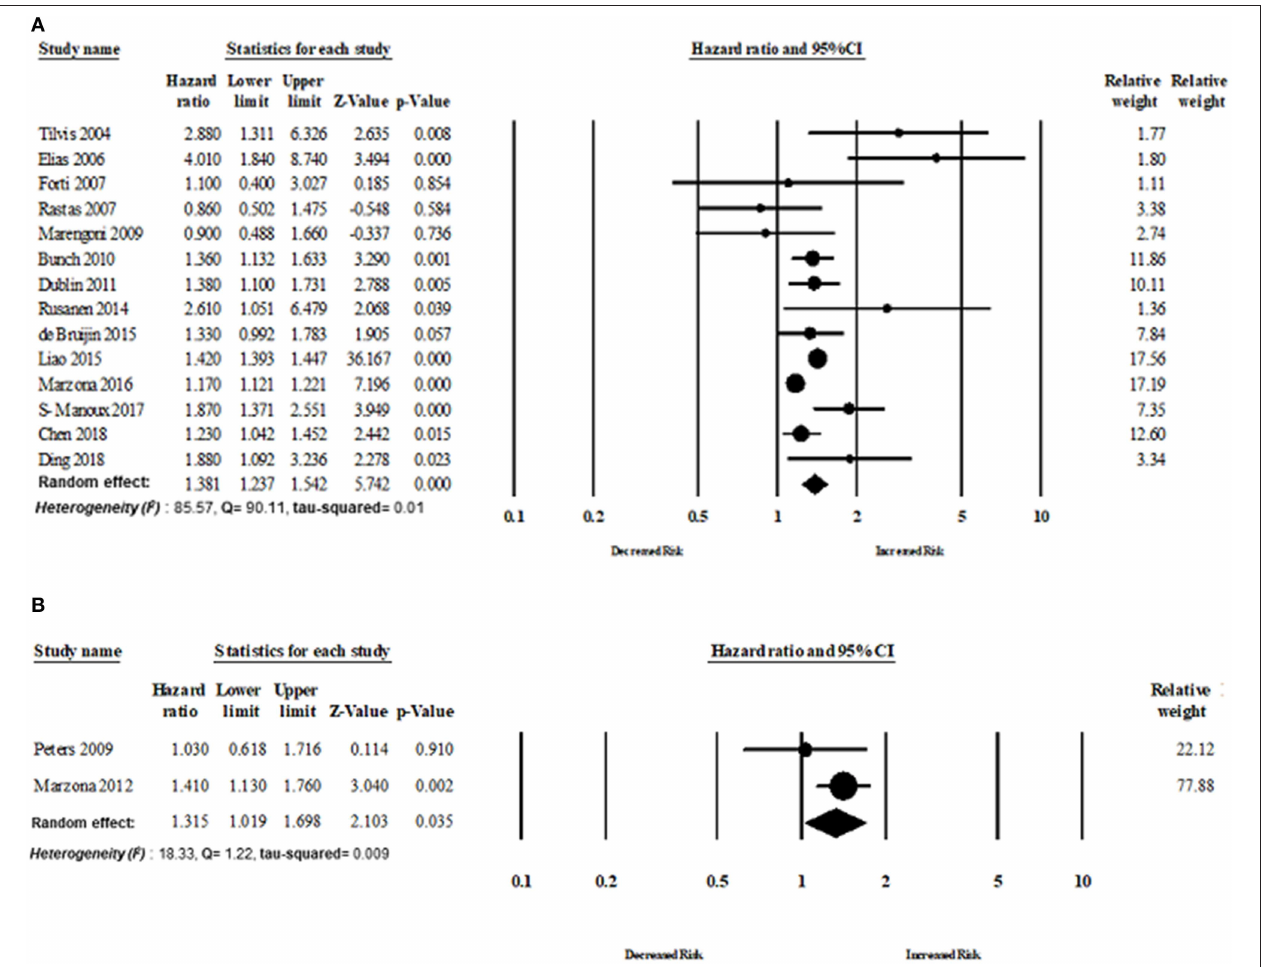
FIGURE 6 | Association between AF and dementia based on study design: (A) cohort study design, (B) randomized control trial.